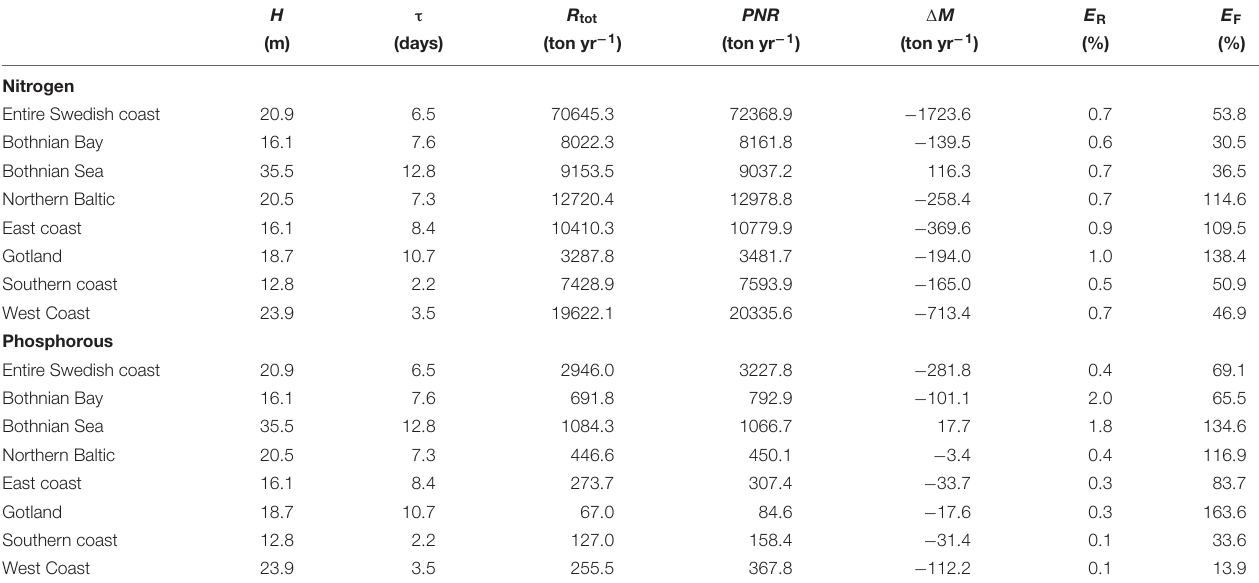
FIGURE 5 | Filter efficiency, E F , of phosphorous (A) and nitrogen (B) , versus the ratio between the depth and the residence time ( H / τ ). The literature data (gray triangles) are from Nixon et al. (1996); Billen et al. (2011), Hayn et al. (2014) and the gray diamonds are values from Almroth-Rosell et al. (2016). The colored dots and stars are from this study (abbreviations in the legend according to Table 1 ). TABLE 2 | Averaged (1995–2014) depth ( H ), residence time ( τ ), total retention ( R tot ), permanent net removal ( PNR ), temporary changes in nutrient storage ( (cid:49) M ), retention efficiency ( E R ) and filter efficiency ( E F ) in the seven major